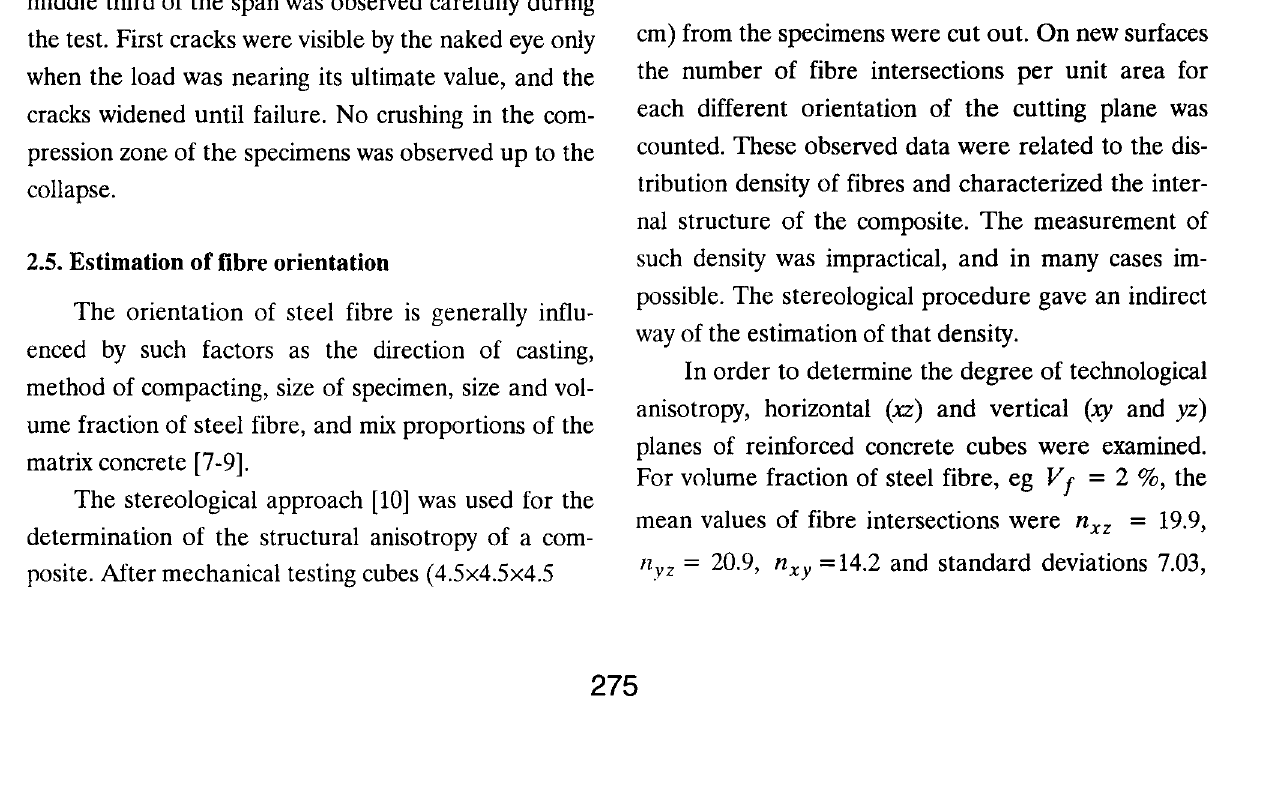
Fig 2. Histograms of fibre intersection numbers n per unit area ( Vr =2 %) and Gauss distribution curves: (a)